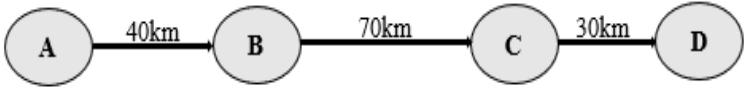
Figure 7. A simple example illustration of an origin–destination road network.